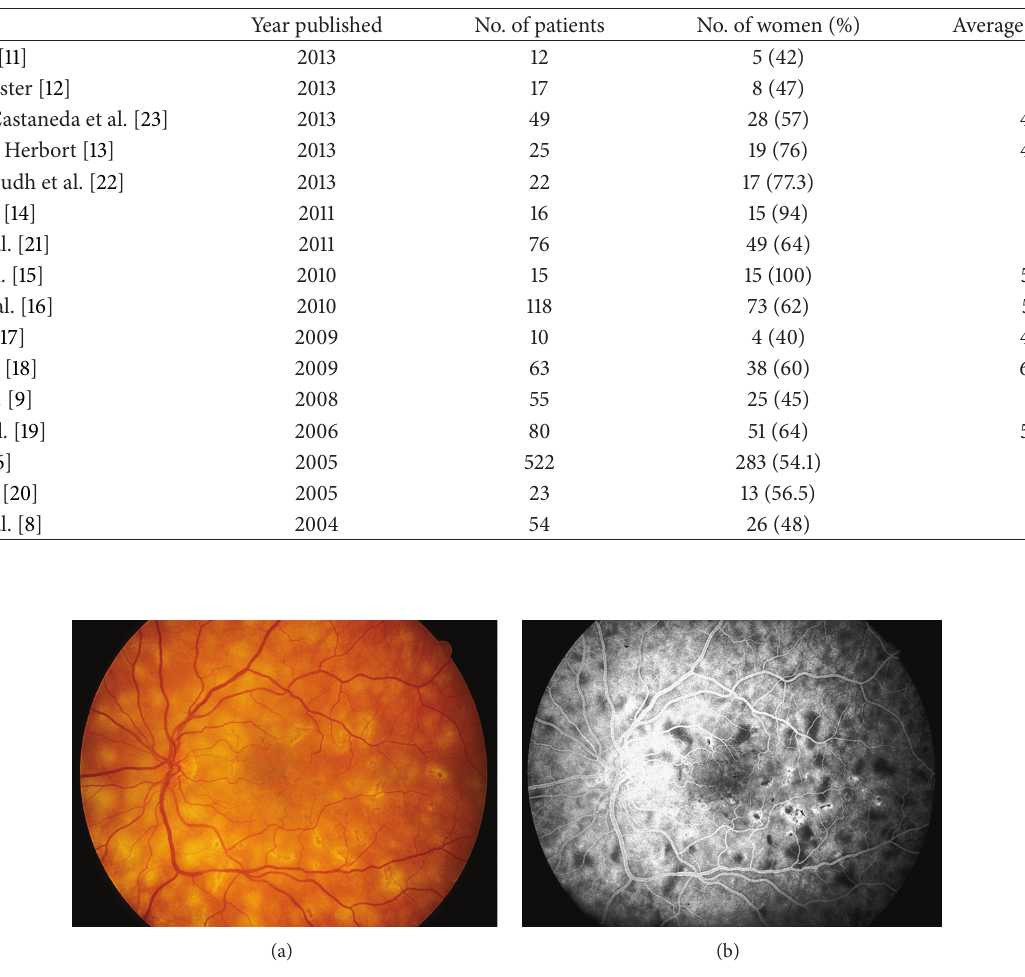
Figure 2: (a) Fundus photograph and corresponding (b) midphase fluorescein angiogram showing blockage of some lesions and the beginning of staining of other lesions as the later phase begins in